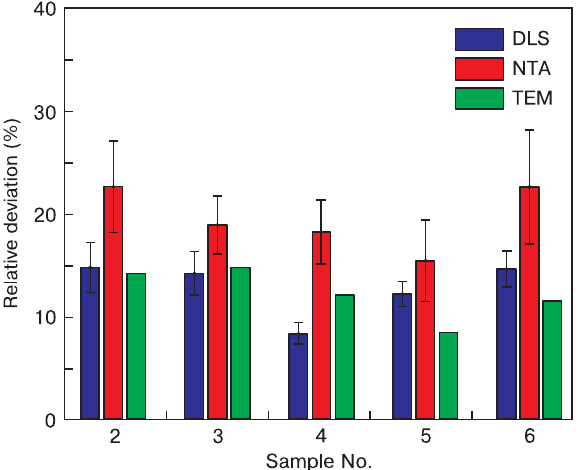
Figure 4. Relative particle size deviation data obtained by DLS, NTA and